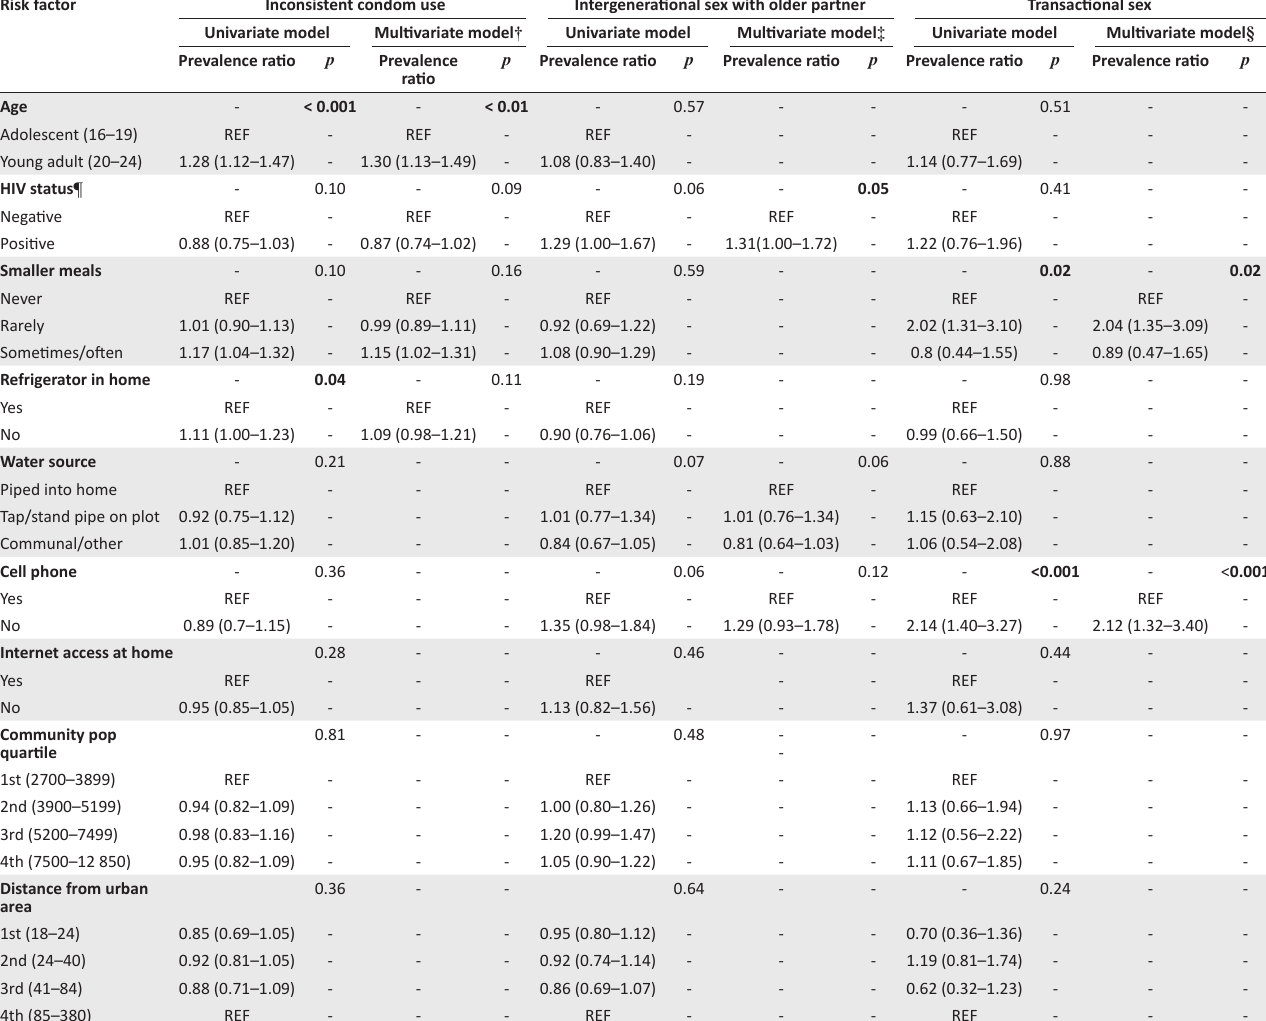
TABLE 3: Univariate and multivariate modelling factors for risky sexual practices among female adolescents and young adults. Risk